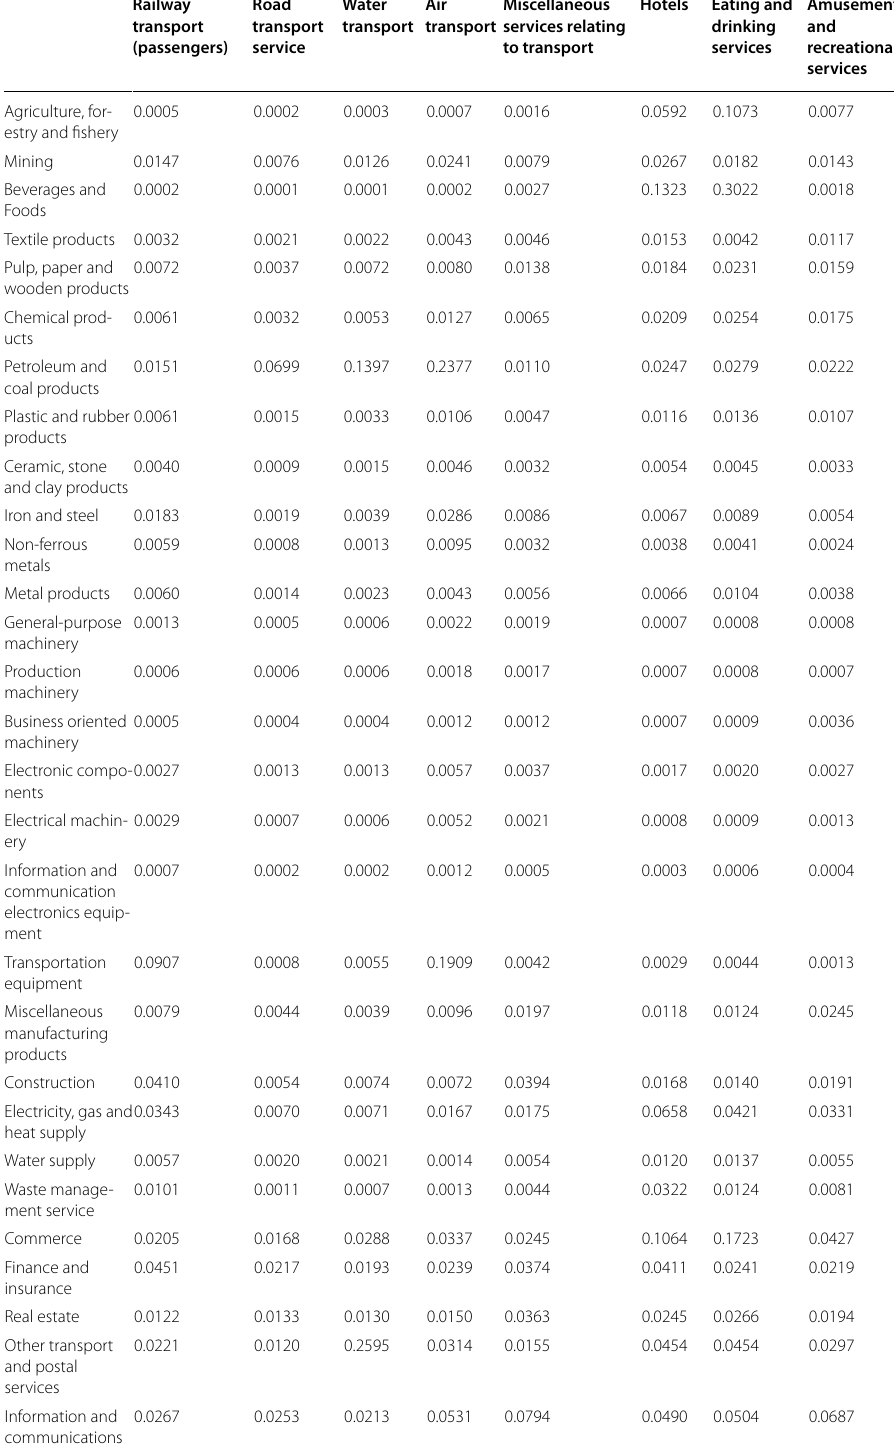
Table 4 Coefficient of internal propagation in other sectors induced by input in tourism ( B 2 )